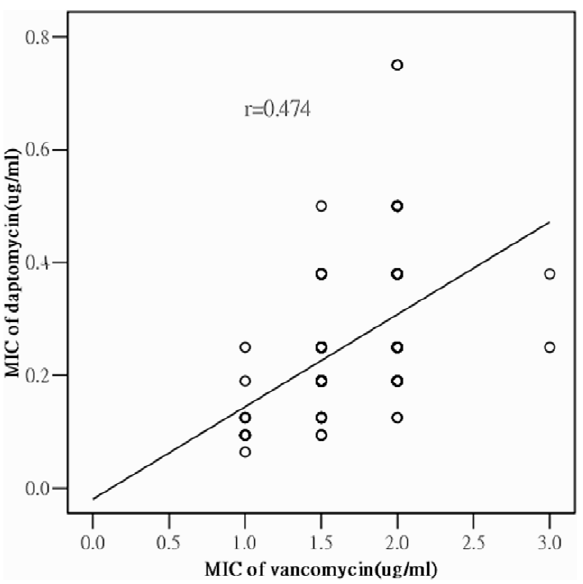
Figure 1. Correlation between vancomycin and daptomycin MICs of 157 MRSA blood isolates determined by E-test; r (Pearson’s correlation coefficient)=0.474.